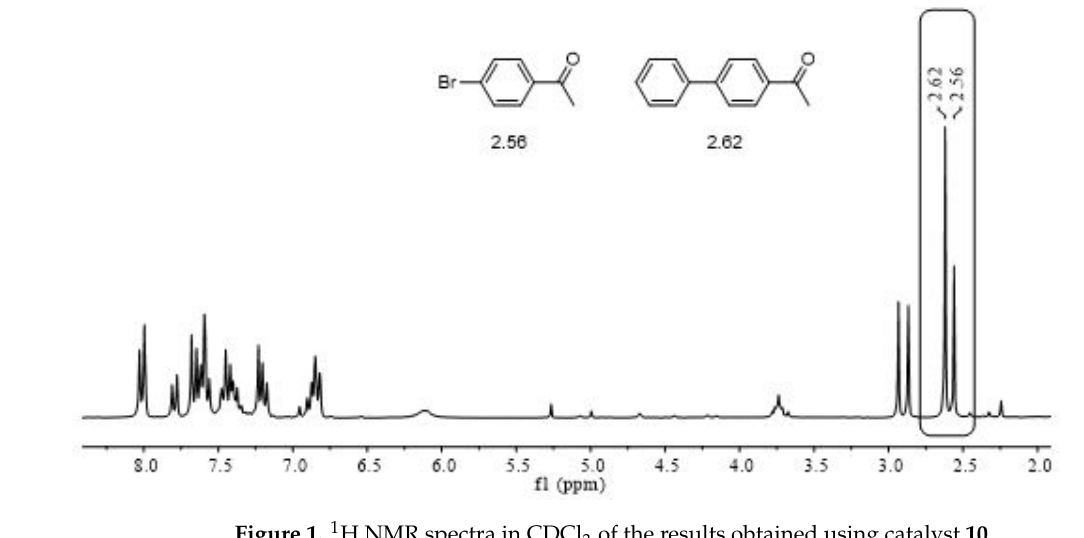
Figure 1. 1 H NMR spectra in CDCl 3 of the results obtained using catalyst 10 .